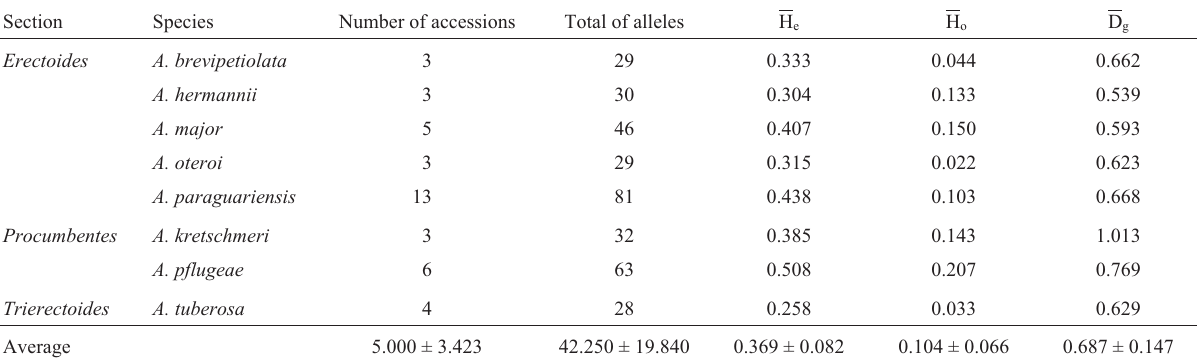
Table 4 - Genetic variability index for species with more than three analyzed accessions. The table shows the total number of alleles, the expected (H e ) and observed (H o ) heterozygosities and the average genetic distance between accessions (D g